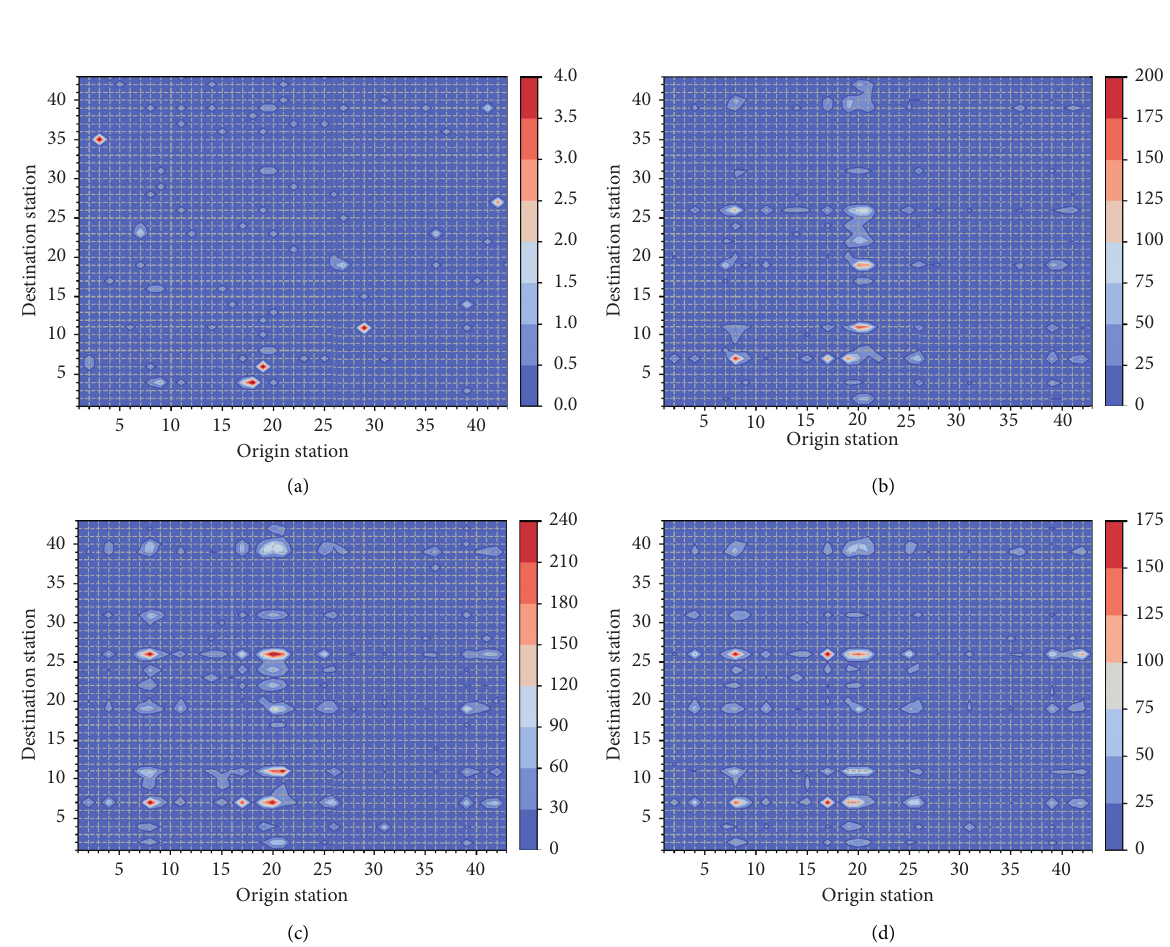
Figure 12: Dynamic OD matrix estimation of passenger flow. (a) OD passenger volume from 7:00 to 7:30. (b) OD passenger volume from 7: 30 to 8:00. (c) OD passenger volume from 8:00 to 8:30. (d) OD passenger volume from 8:30 to